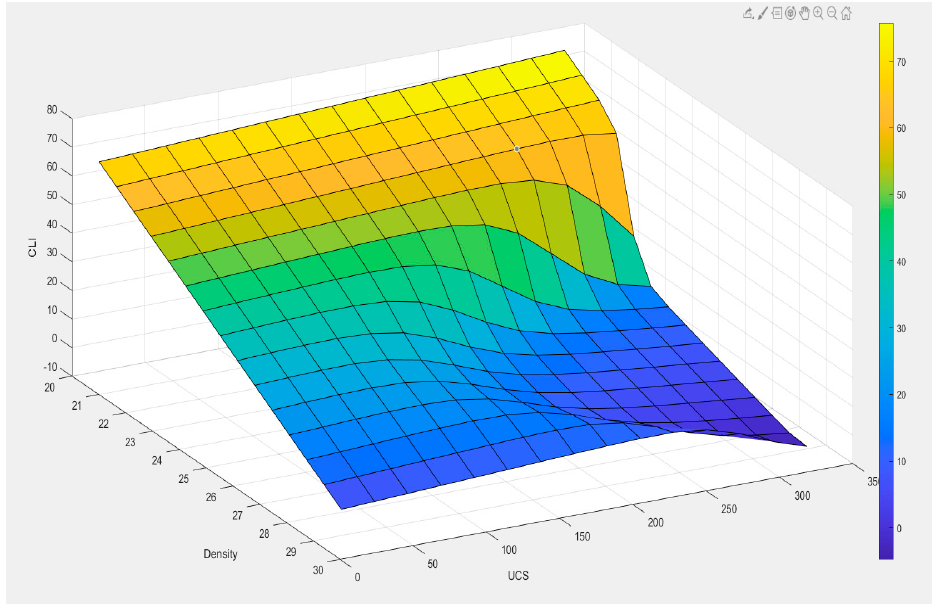
Figure 19. Fuzzy logic surface view for inputs (D, UCS) and CLI.